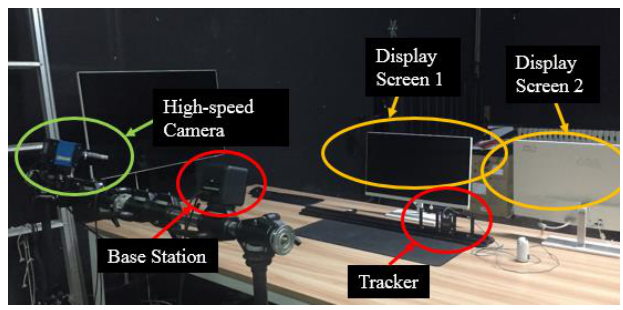
Figure 10. Latency test environment.